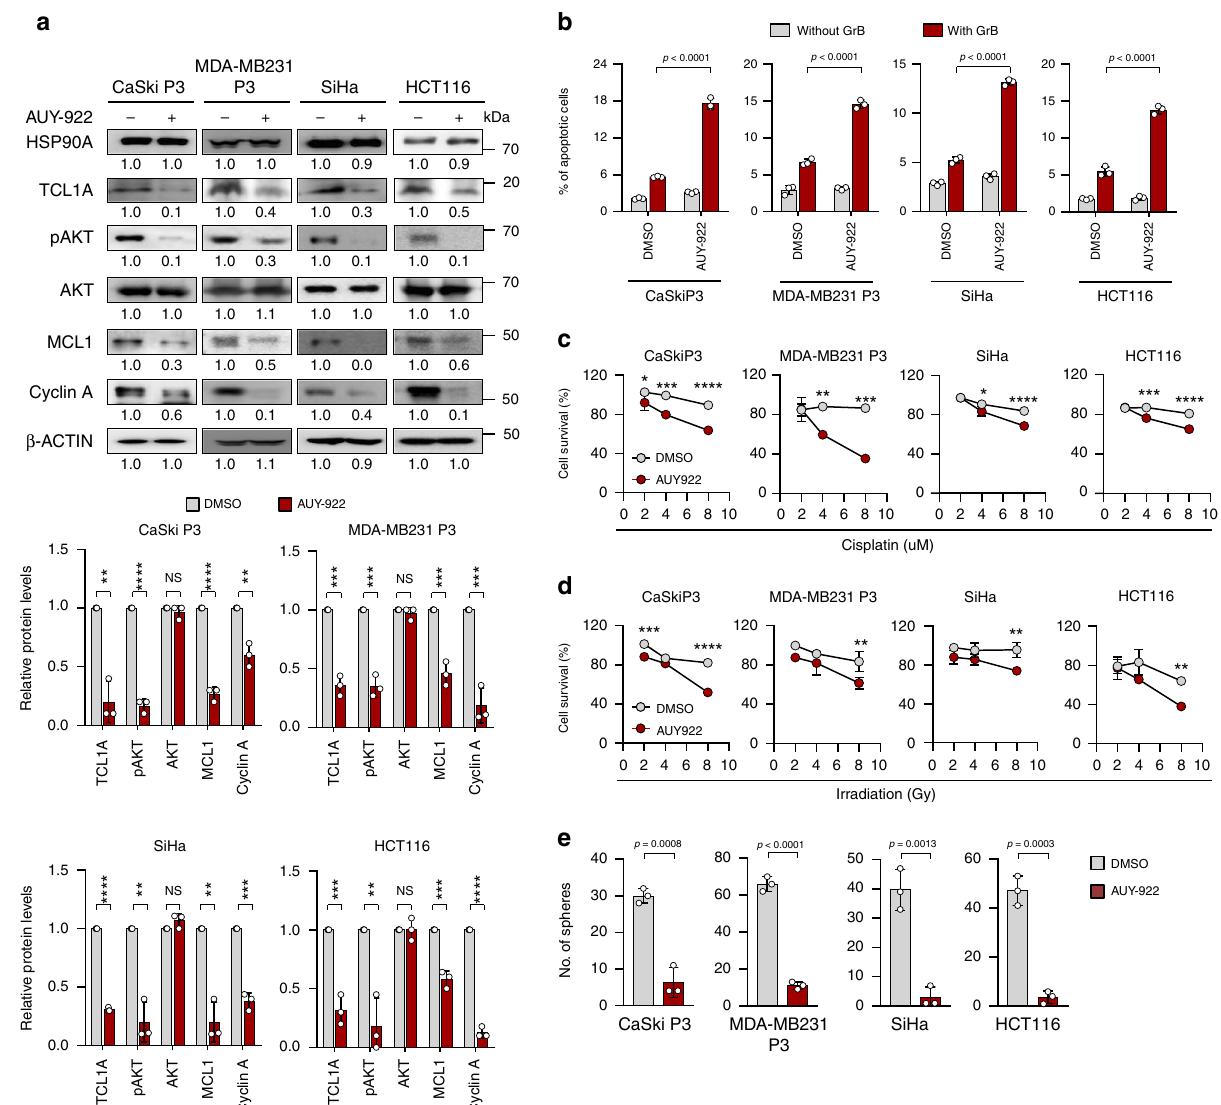
Fig. 5 HSP90A inhibition reduces multi-aggressive properties of NANOG high tumor cells. a – e CaSki P3, MDA-MB231 P3, SiHa, and HCT116 cells were treated with DMSO or AUY-922. a Levels of HSP90A, TCL1A, pAKT, AKT, MCL1, Cyclin A, and β ‐ ACTIN were proved by Western blot. β -ACTIN was included as an internal loading control. Numbers below blot images indicate the expression as measured by fold change. Graph depicts the experimental quantitation based on at least three independent experiments. b Flow cytometry analysis of the frequency of apoptotic (active caspase-3 + ) cells in the cells after intracellular delivery of granzyme B for 4 h. c and d Cells were treated with indicated concentrations of cisplatin c and irradiation d . The percentage of viable cells was determined by trypan blue exclusion assay at 24 h after either drug challenge or irradiation. e Sphere-forming capacity of the cells in low- density suspension culture. All experiments were performed in triplicate. The p -value by two-tailed Student ’ s t test a , one-way ANOVA b and e or two-way ANOVA c and d are indicated. * p < 0.05, ** p < 0.01, *** p < 0.001, **** p < 0.0001. Data represent the mean ± SD. Source data are provided as a Source Data fi